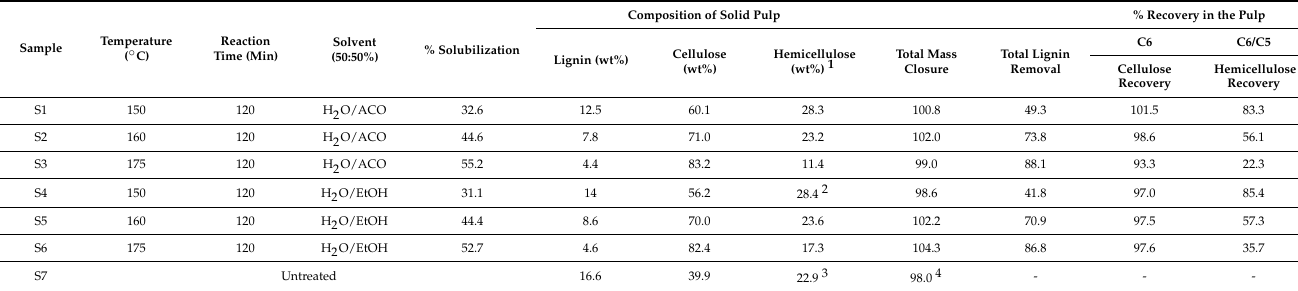
Table 1. Pretreatment conditions, compositional analysis of solid pulps, lignin removal and % recovery of cellulose and hemicellulose. Standard error is ≤ 2.5% in all